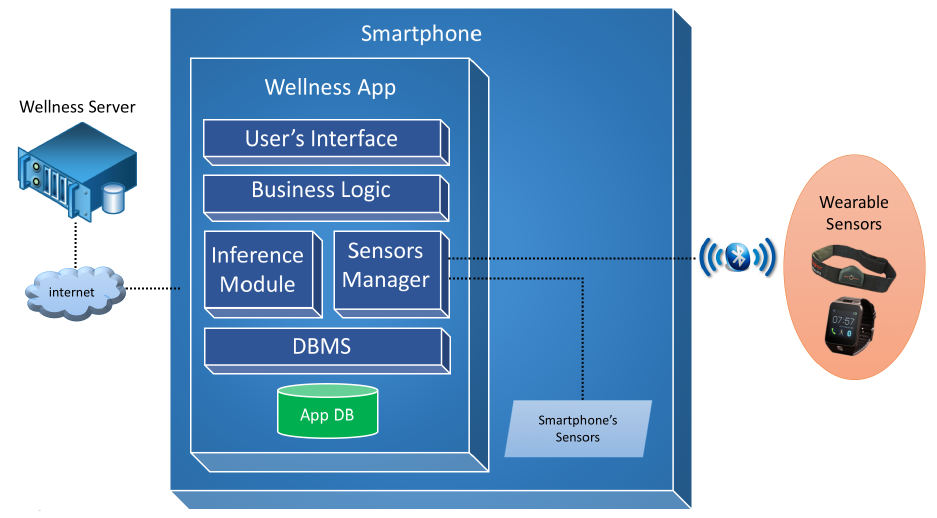
Figure 1. Overview of the software